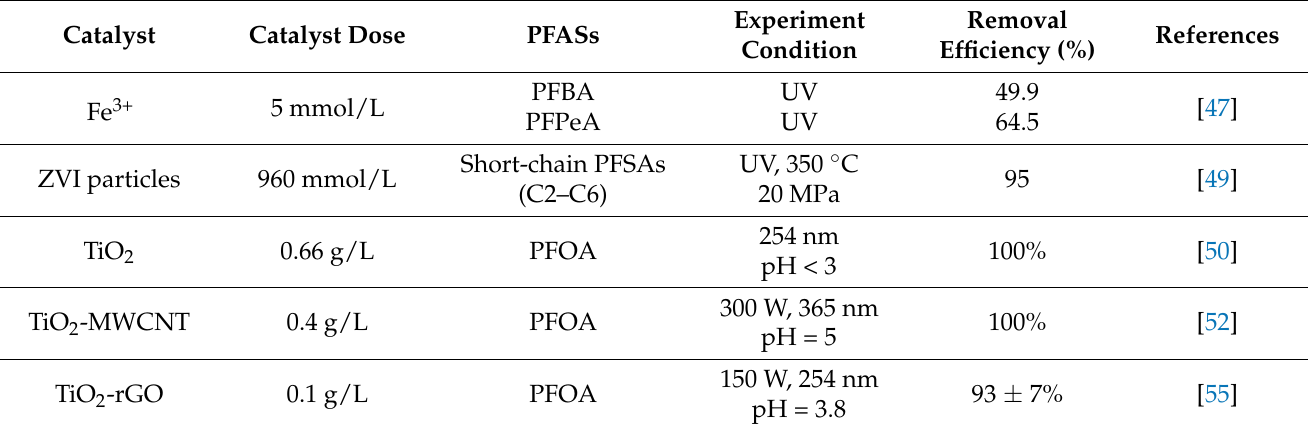
Table 4. Photocatalytic efficiency of PFASs with different